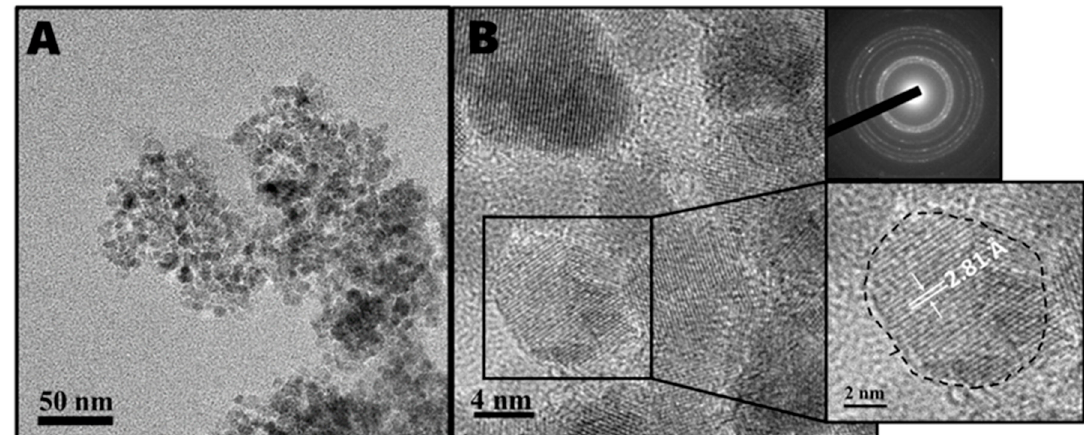
Figure 2. HRTEM images after 10 cycles indicating ZnO nanoparticle aggregates: ( A ) Large-scale image showing an aggregate consisting of small ZnO crystallites. ( B ) Small-scale image of nanocrystallites highlighting a crystallite with d-spacing of 2.81 angstrom fitting the (1,0,0) plane of ZnO (bottom right inset), and a SAED pattern of nanocrystalline aggregates (upper right inset).